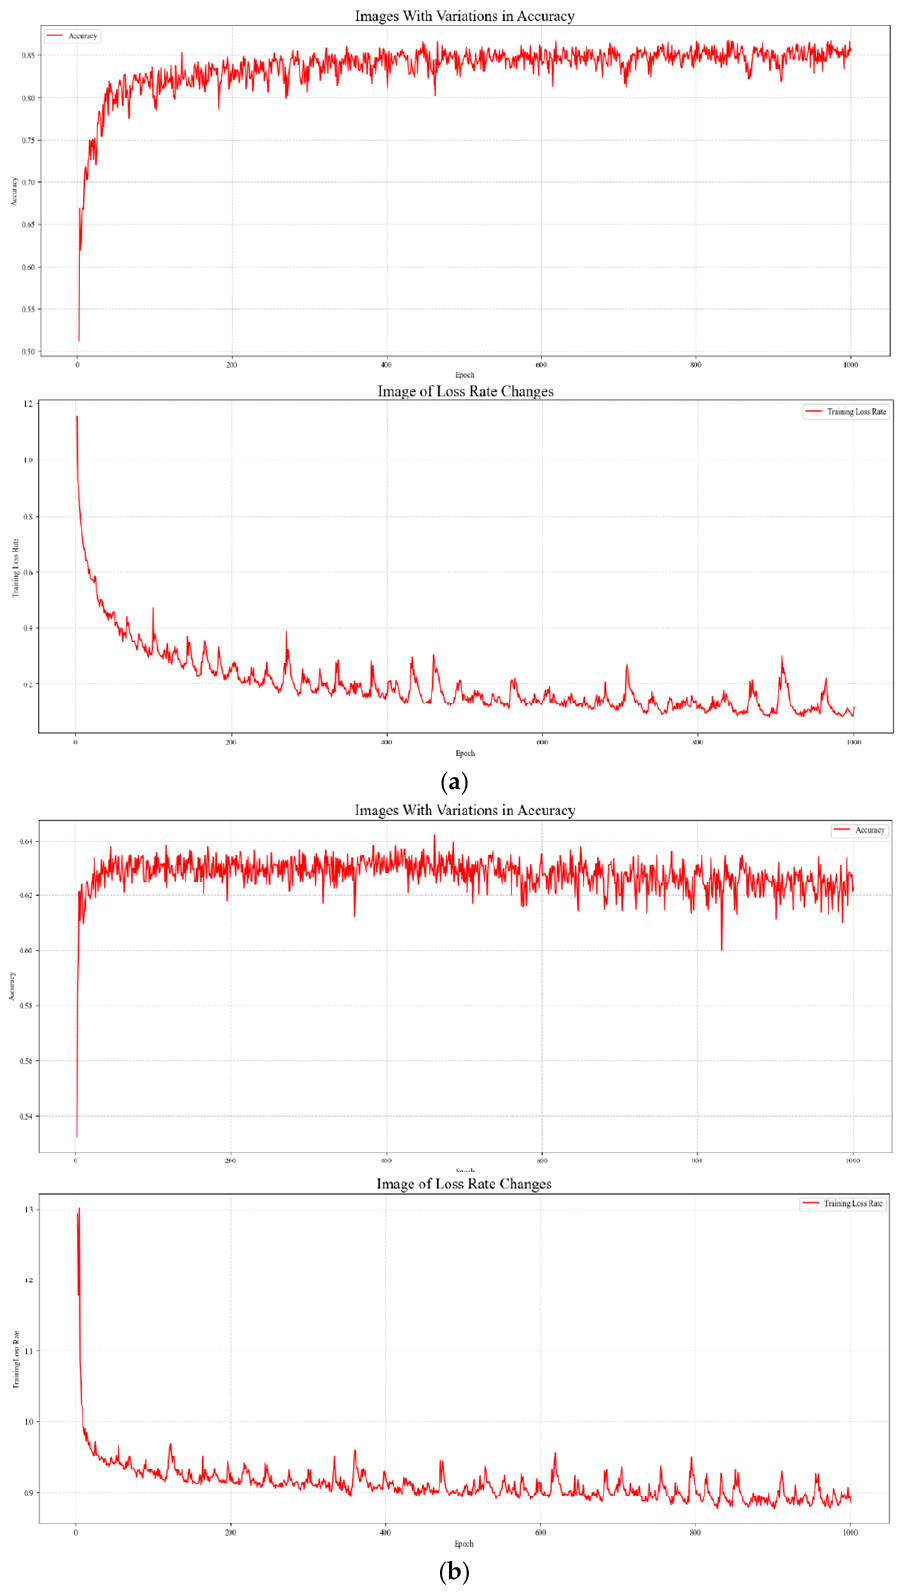
Figure 21. ( a ) Training accuracy and loss change of GPS. ( b ) Training accuracy and loss change of VIBE.